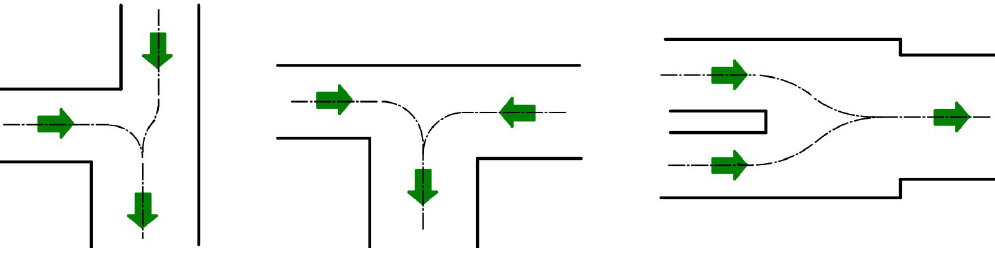
Figure 11. Examples of confluence